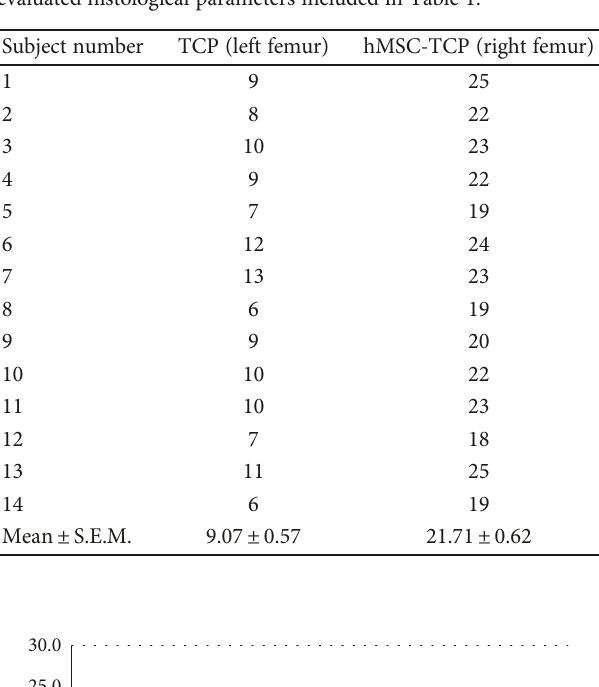
Table 2: Score of the subjects included in the study according to the evaluated histological parameters included in Table 1.